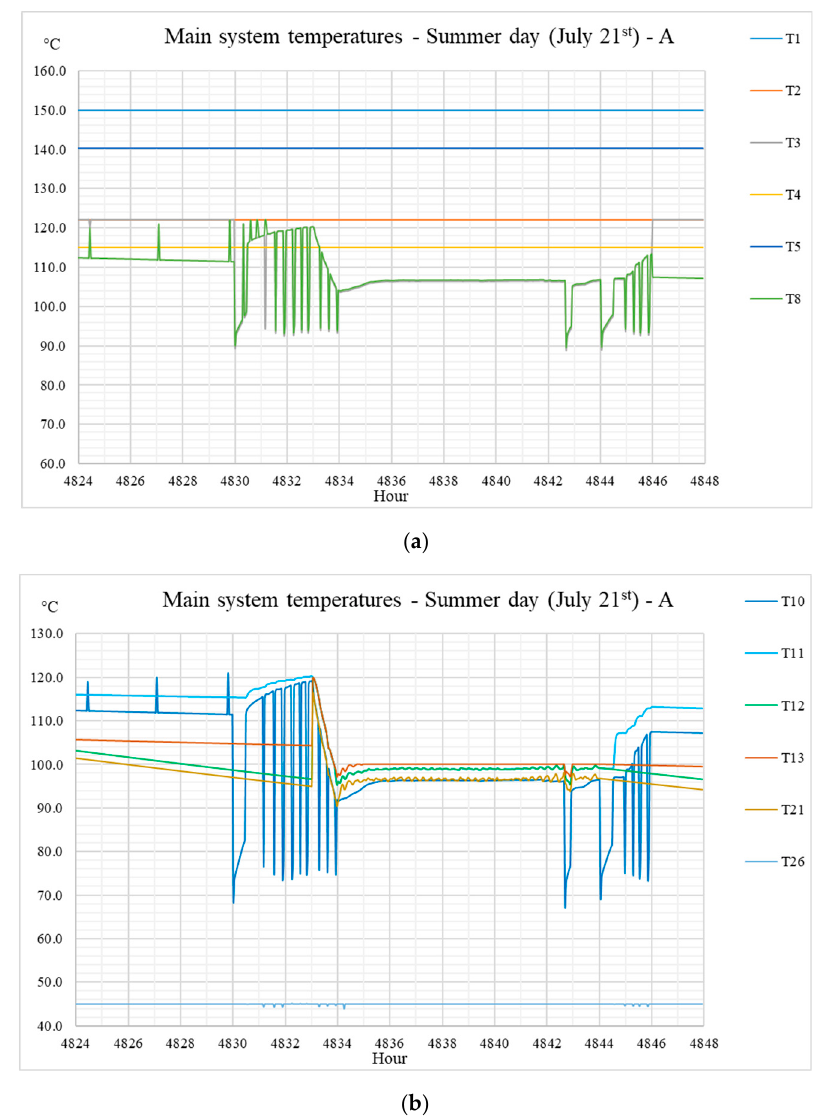
Figure 8. Main system temperatures: summer day (21 July—A). from T 1 to T 8 ( a ); from T 10 to T 26 (b).